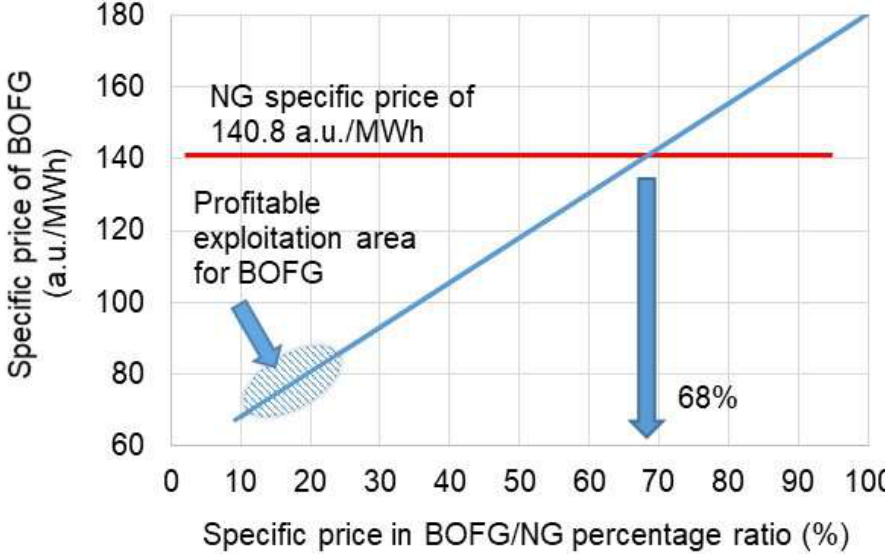
Figure 9. Specific prices for BOFG and NG vs. percentage ratio between BOFG and NG prices.